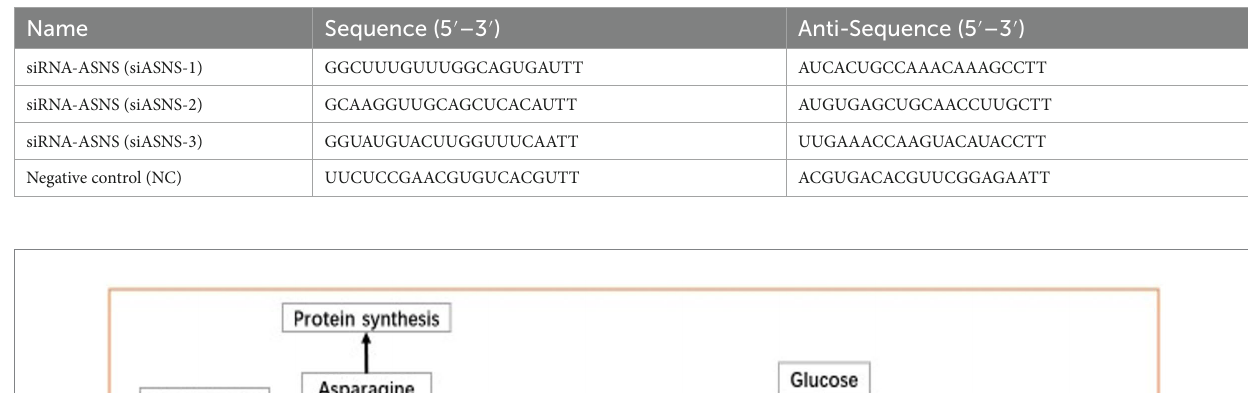
TABLE 3 Interfering RNA sequence of ASNS.